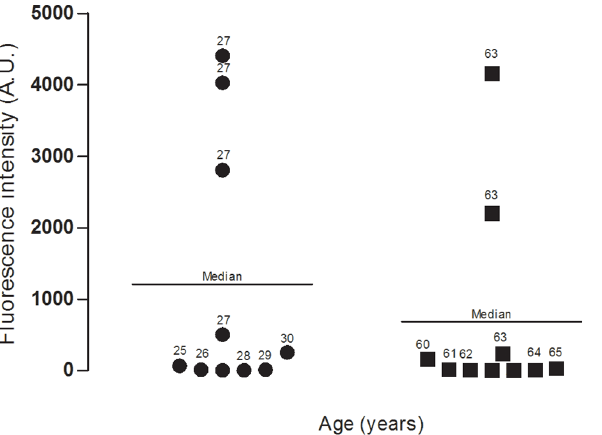
Fig 4. Unaltered basal levels of autophagy marker LC3 in human skin sections from young and old donors. Data represent combined fluorescence levels (arbitrary units) in the skin sections from 10 young and 10 old donors; at least 5 microscopic pictures from each donor were analyzed in this data set. Median value is represented by a line (p =